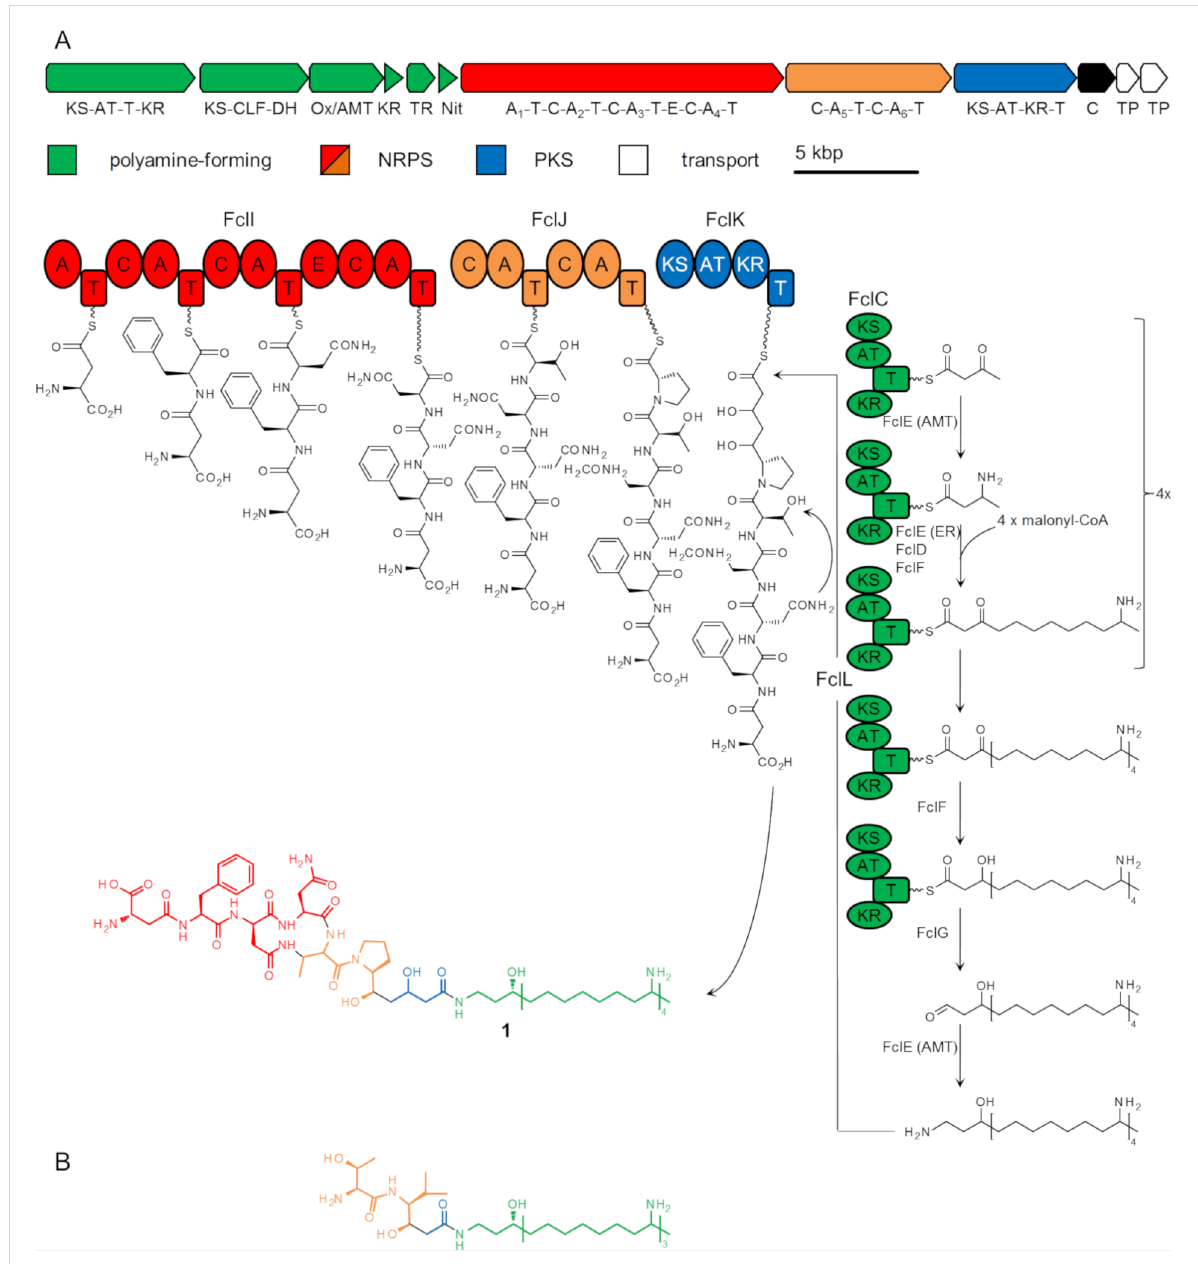
Figure 1: General biosynthesis of fabclavine Ia ( 1 ) in X. budapestensis (A) and representation of a shortened fabclavine derivative from X. szentir- maii (B), resulting from the alternative biosynthesis start at FclJ (the Figures were adapted and modified from [20] and [22]. KS: ketosynthase, AT: acyltransferase, T: thiolation domain, KR: ketoreductase, CLF: chain length factor domain, DH: dehydratase, Ox: 2-nitropropane dioxygenase (enoyl reductase), AMT: aminotransferase, TR: thioester reductase, Nit: nitrilase, A: adenylation, C: condensation, E: epimerization, TP: